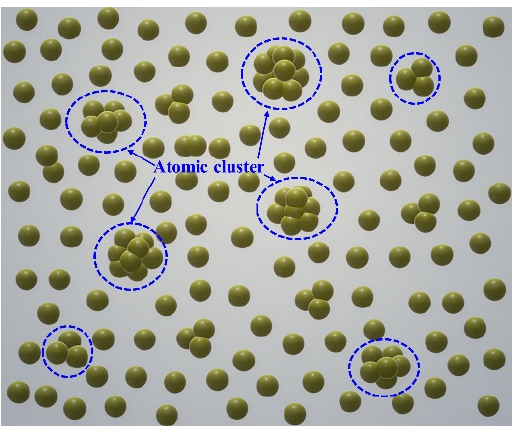
Figure 10. Schematic drawing representing the structure of liquid metal.